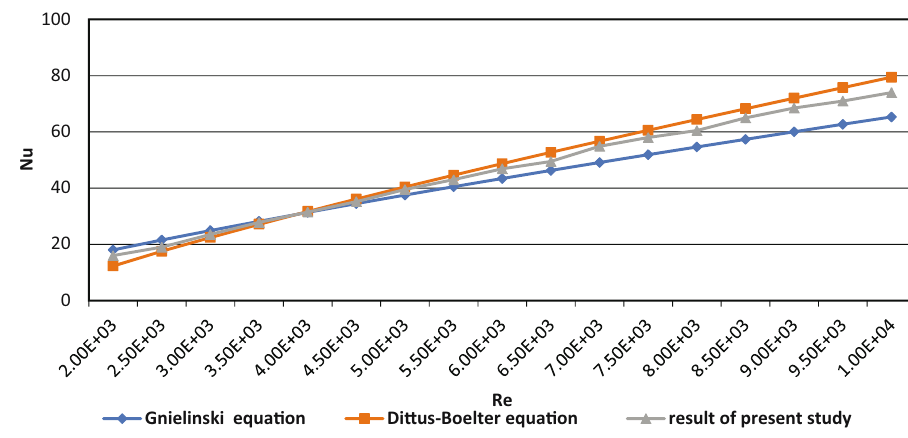
Figure 4: The comparison of Nusselt number of ba ffl e - free geometric model with experimental